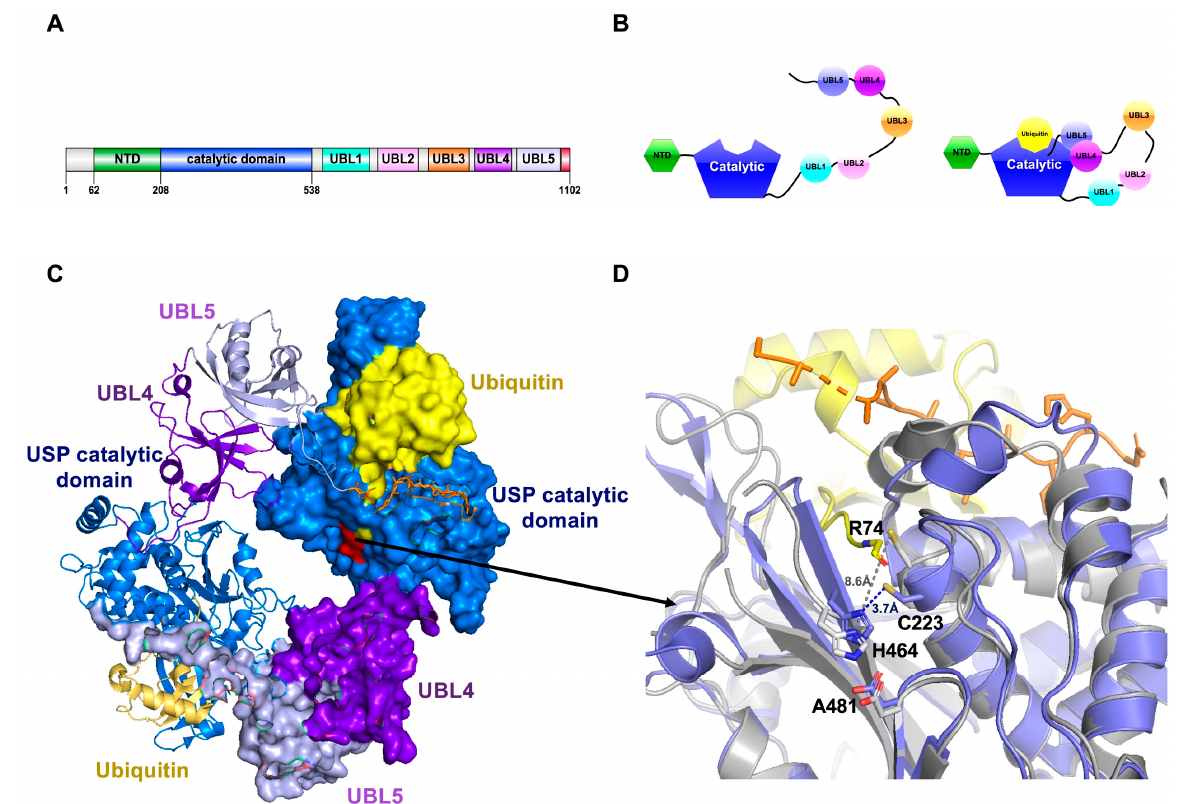
Figure 1. Active site rearrangements in USP7. ( A ) Schematic representation of the USP7 domain organization. ( B ) Model for the activation of USP7 by ubiquitin and ubiquitin-like modifiers (UBL) domains (different colors). ( C ) Crystal structure of the dimer of the USP7CD-UBL45-ubiquitin complex. Ubiquitin (yellow), the C-terminal peptide after UBL5 (orange). ( D ) Comparison of the active sites between USP7CD-UBL45-Ub and USP7CD. Active USP catalytic domain (blue), non-active USP catalytic domain (gray). Dotted lines are distances between active site Cys and His residues (PDB: 5JTV, 5FWI).